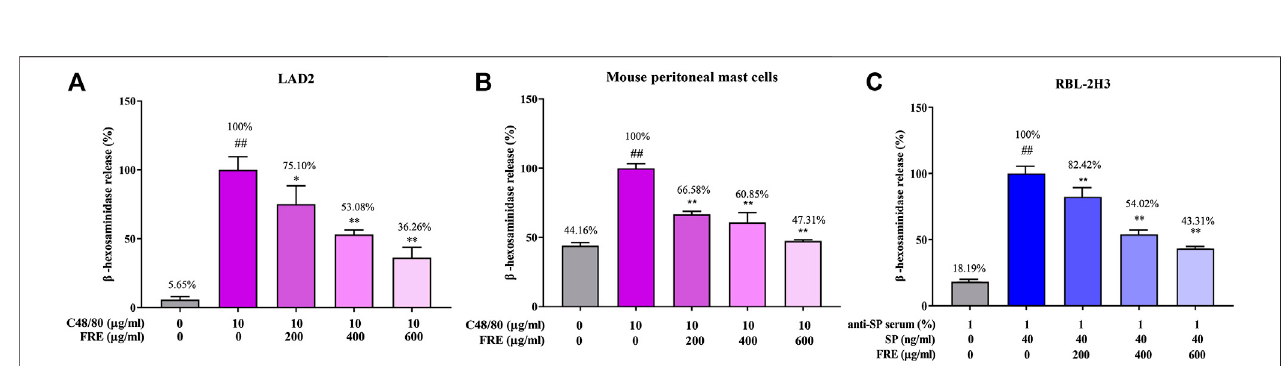
FIGURE 3 | FRE inhibits both Mrgpr- and IgE/Fc ε RI-mediated MC degranulation in vitro ( n (cid:2) 3). (A,B) Effect of FRE on Mrgpr-mediated MC degranulation in vitro . LAD2 (A) and MPMCs (B) were pretreated with FRE for 30 min and then exposed to C48/80 (10 μ g/ml) for another 1.5 h. Supernatants were collected for the β -hexosaminidase release assay. ## p < 0.01 vs. control and * p < 0.05, ** p < 0.01 vs. C48/80 alone group. (C) Effect of FRE on IgE/Fc ε RI-mediated MC degranulation invitro .ThesensitizedRBL-2H3cellswerepretreatedwithFREfor30 minandthenchallengedwithSP.The β -hexosaminidasereleaseassaywasconducted1.5 h after SP stimulation. ## p < 0.01 vs . negative control (the anti-SP serum sensitization alone group) and ** p < 0.01 vs . model group (the both anti-SP serum sensitization and SP challenge group).